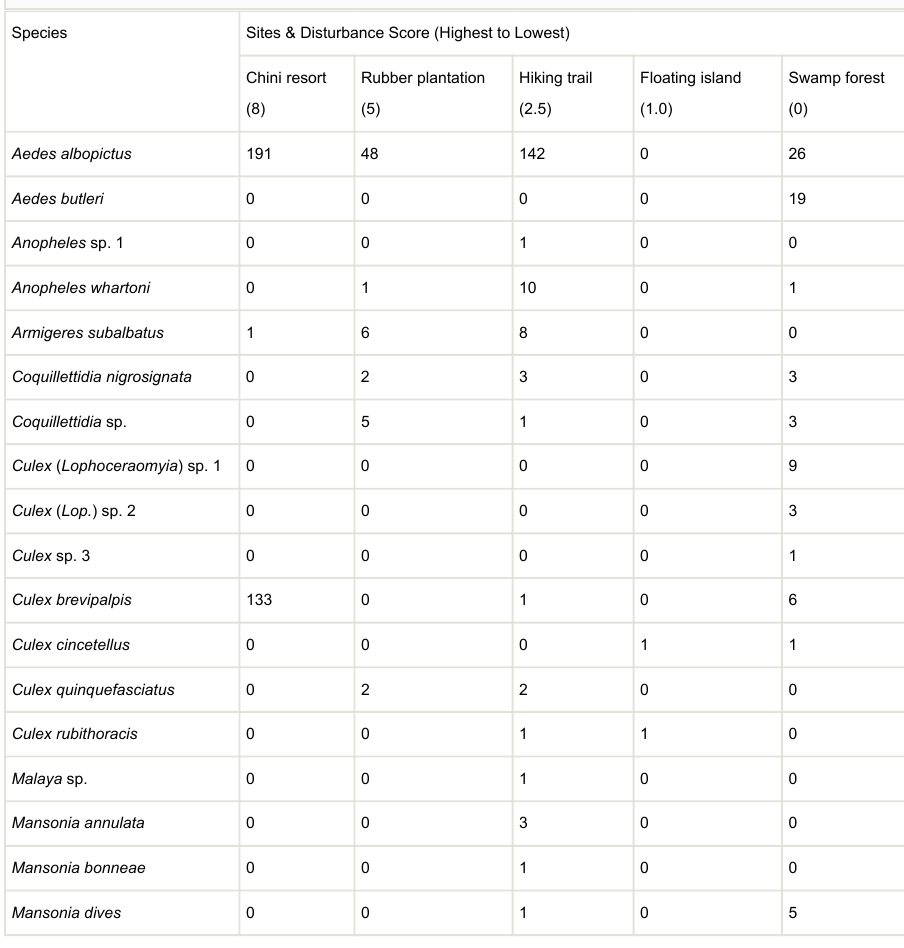
Hiking trail (2.5)